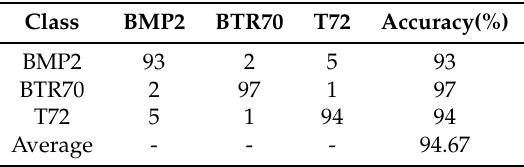
Table 2. Number of chosen